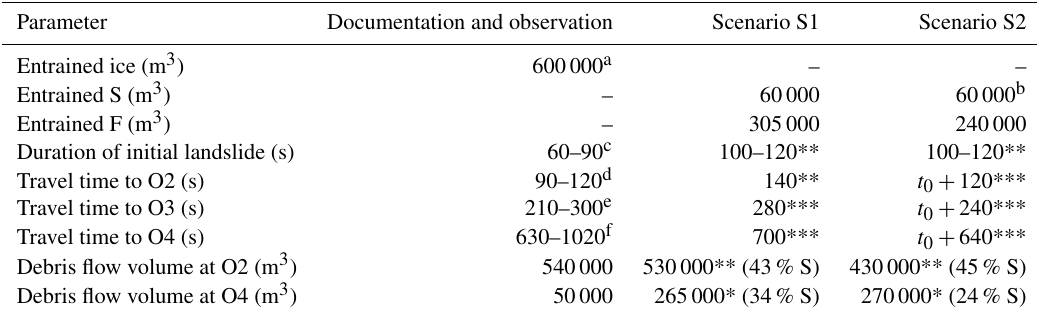
Table 3. Selected output parameters of the simulations for the scenarios S1 and S2 compared to the observed or documented parameter values. S is solid, F is fluid, fractions are expressed in terms of volume, and t 0 is time from the initial release to the release of the first debris flow surge. Reference values are extracted from Amt für Wald und Naturgefahren (2017), Bonanomi and Keiser (2017), and WSL (2017). *** is empirically adequate (within the documented range of values). ** is empirically partly adequate (less than 50% away from the documented range of values). * is empirically inadequate (at least 50% away from the documented range of values). The arithmetic means of minimum and maximum of each range are used for the